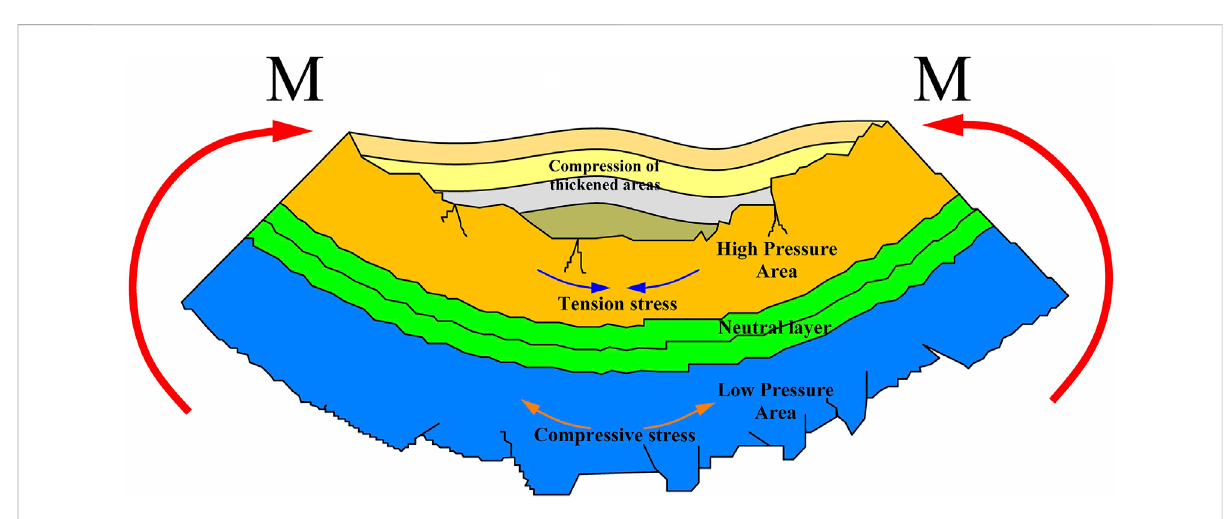
FIGURE 3 Schematic diagram of pressure zoning of the synclinal